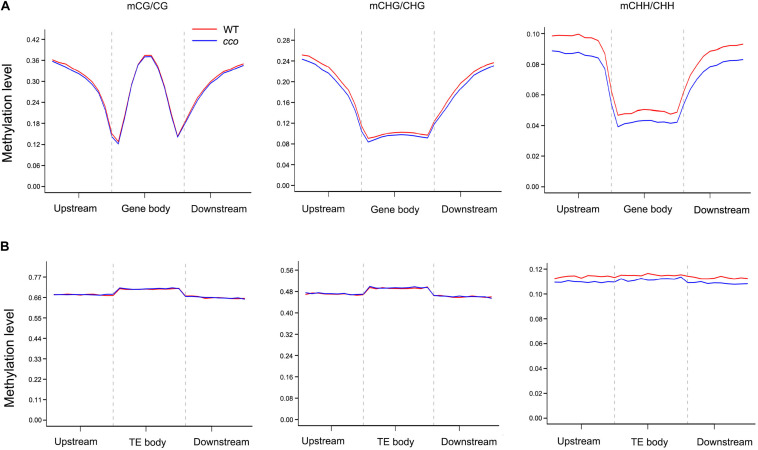
DNA methylation patterns of gene body and transposon regions in soybean cotyledons of the WT and the cco mutant. (A) Methylation levels of CG, CHG, and CHH contexts are displayed for each bin within gene body regions and their 2-kb up- and downstream regions. (B) Methylation levels of CG, CHG, and CHH contexts are displayed for each bin within transposons and their 2-kb up- and downstream regions. Gene body and transposon regions (with their flanking regions) were all equally divided into 20 bins. The methylation level of each bin is shown on the Y-axis.